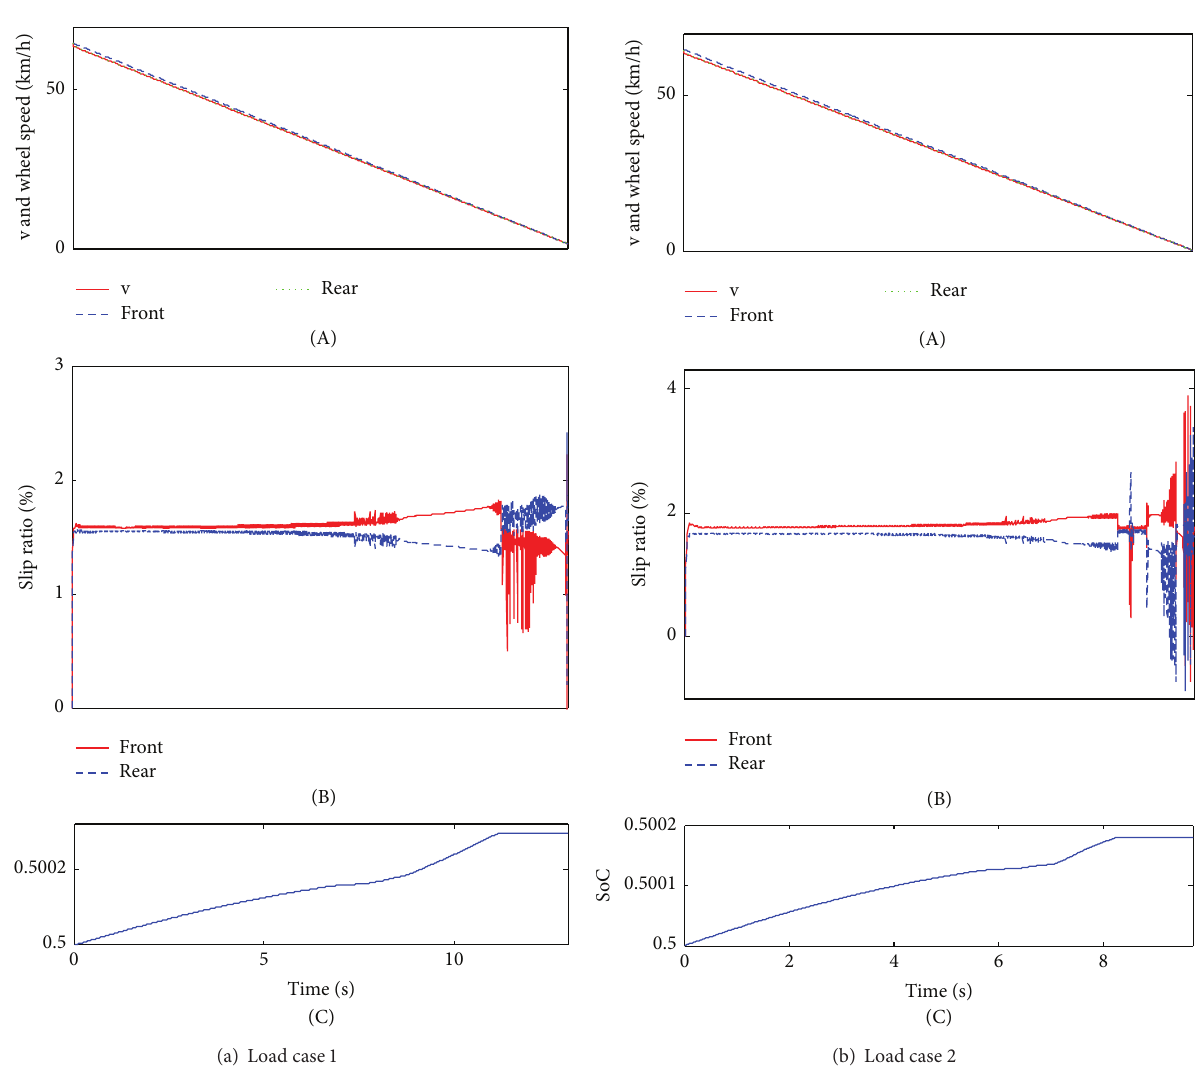
Figure 6: The simulation results of braking case